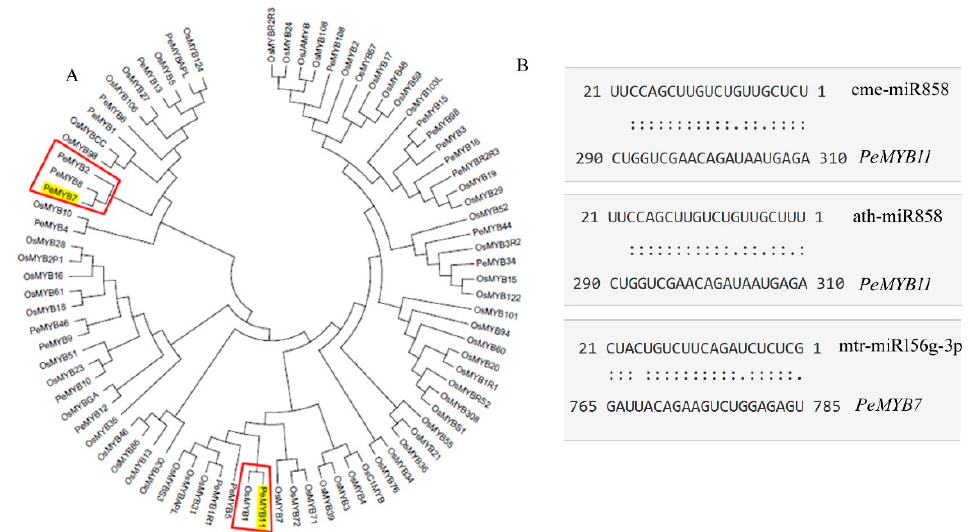
Figure 8. Identification of PeMYB7 , PeMYB11 and their target sites by miR156g, miR858. ( A ) Phylogenetic tree inferred from the MYB sequences of Phalaenopsis equestris and Oryza sativa ; ( B ) Identification of target sites of miR156 and miR858 in PeMYB7 and